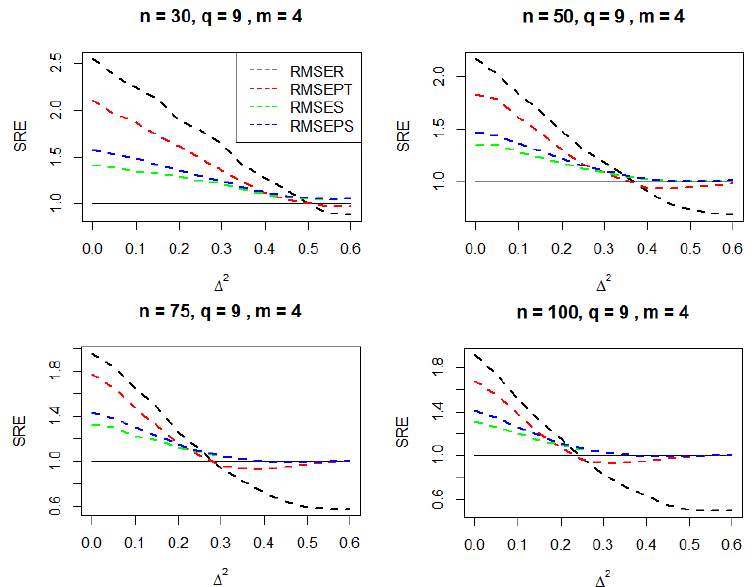
Figure 2. SRE of the restricted, pretest and shrinkage estimators with respect to ˆ θ U when ( m , q ) = ( 4,9 ) and for different sample sizes.